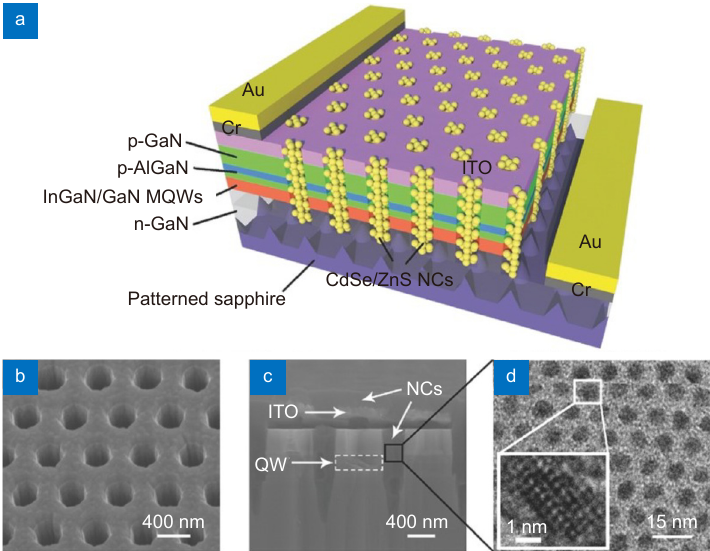
Fig. 3 | Structures of realizing the NRET from chip to QDs 33 . Figure reproduced with permission from John Wiley and